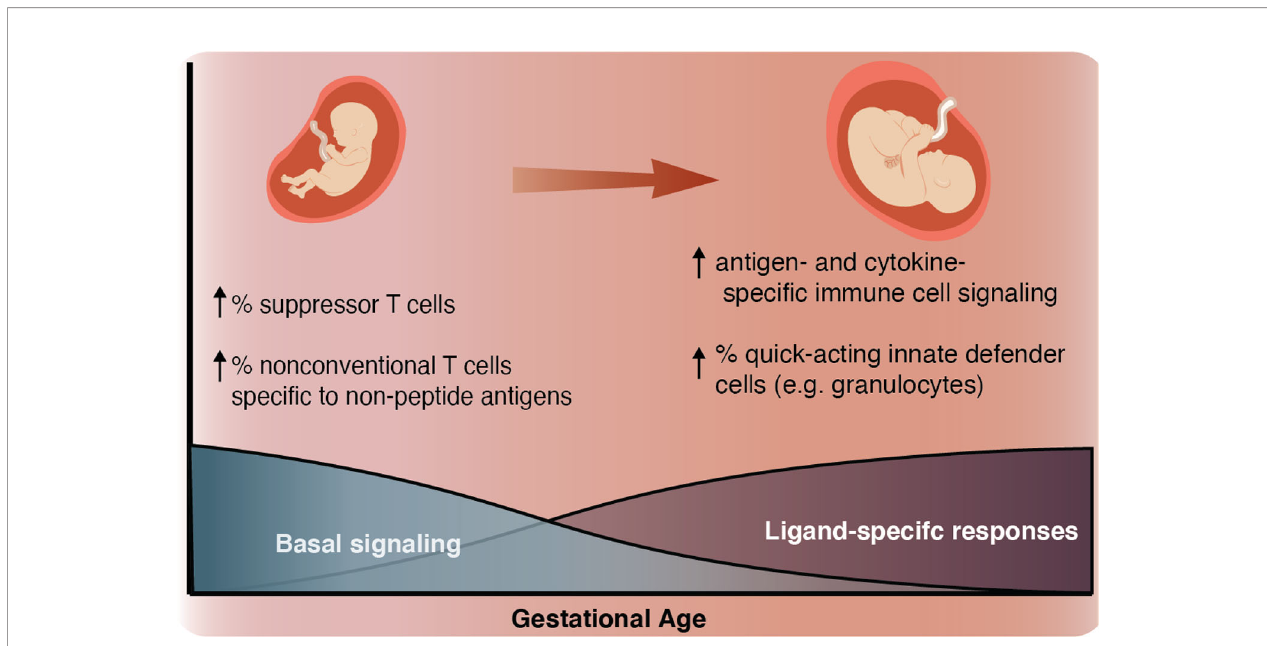
FIGURE 7 | Summary schematic As GA advances, we observed an increase in ligand-speci fi c immune signaling coupled with a decrease in non-speci fi c basal signaling (bottom). As a complement to this change in signaling patterns, we also described an inverse relationship between GA and the prevalence of suppressor- type T cells (T reg cells and possibly CD161 + CD4 + T cells), which have the potential to inhibit antigen-speci fi c in fl ammation and prevalence of non-conventional innate-like T cells such as NKT-like cells and CD8 + CD161 + T cells (classically associated with MAIT cells) (top left). As GA advances the proportion of these inhibitory and non-conventional T cells decreases, the responsiveness of both innate and adaptive cells to antigen (LPS) and cytokine (IFN a and IL-2, IL-4, and IL-6) stimulation increases, and the population of quick-acting innate defender cells increases (top